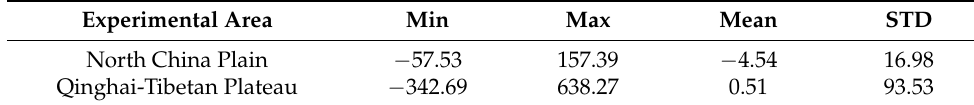
Figure 1. Topography maps. Table 1. Statistics of the UCSD gravity data. Unit: mGal.